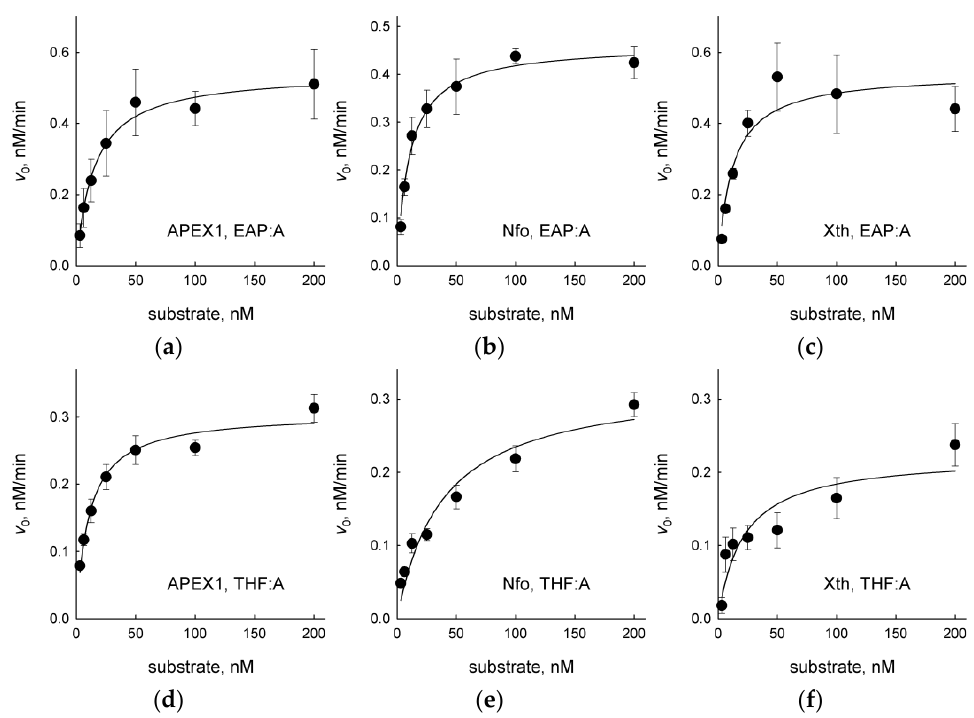
Figure 5. Kinetic curves of AP endonucleases cleaving EAP:A ( a – c ) or THF:A substrates ( d – f ). ( a , d ), APEX1; ( b , e ), Nfo; ( c , f ), Xth. Mean ± S.D. of three independent experiments is shown. Table 2. Kinetic parameters of cleavage of THF- and EAP-containing substrates by AP endonucle- ases.